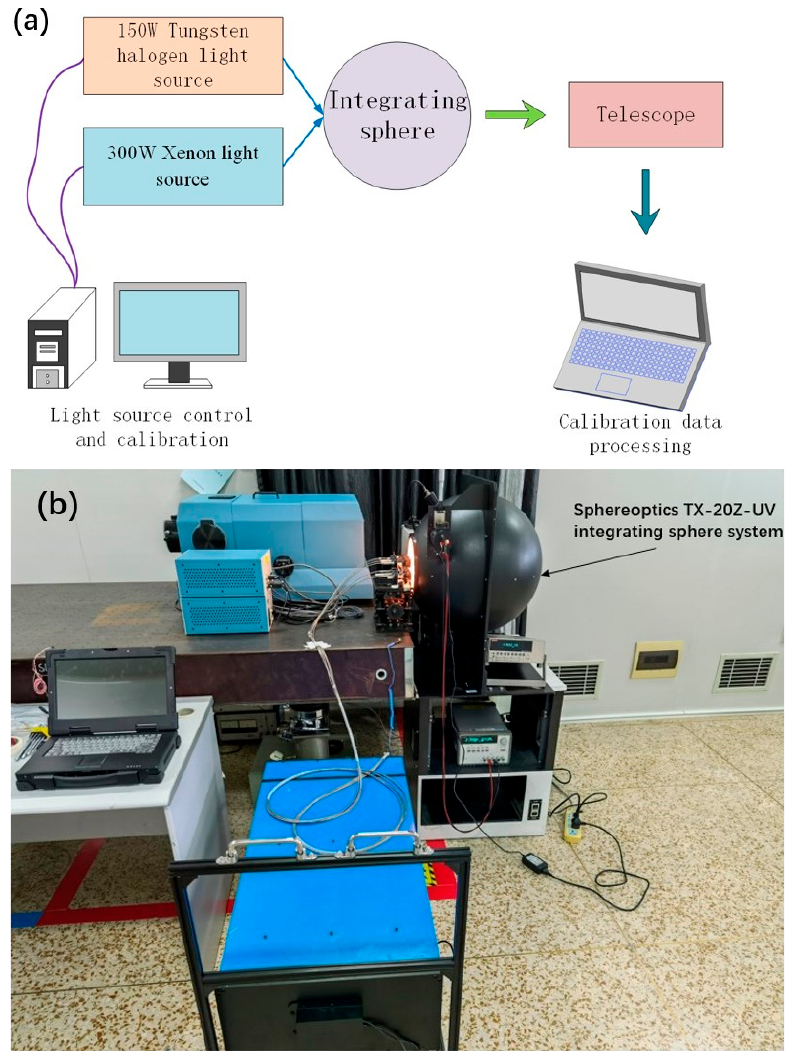
Figure 18. ( a ) Schematic of the radiance calibration of the instrument; ( b ) Instrument placement during radiation calibration evaluation.